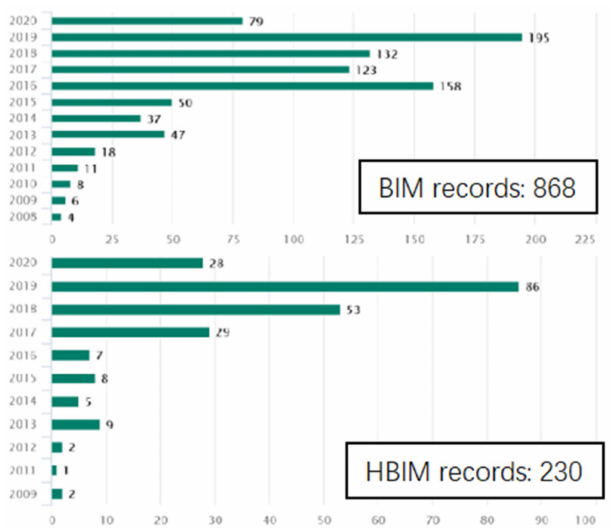
Figure 2. BIM and HBIM search records on the Engineering Village